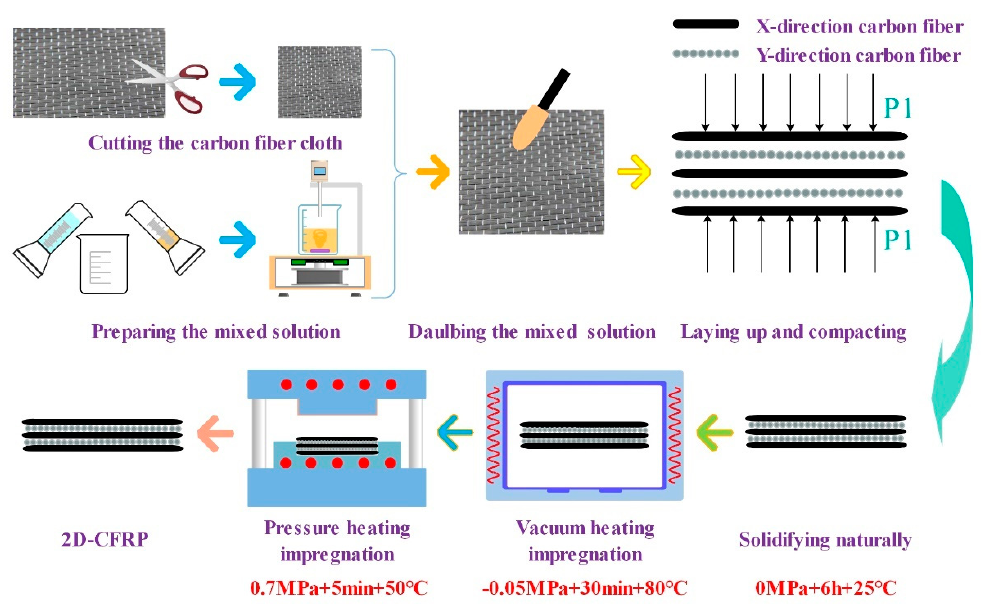
Figure 8. Schematic diagram of the process of preparing 2D-CFRP by the VIHPS.